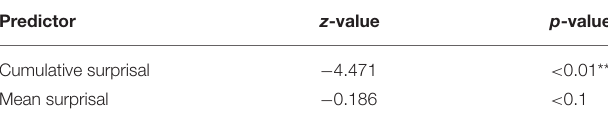
TABLE 7 | Most influential effects in the final GLM predicting position, 1750–1800. Predictor z -value